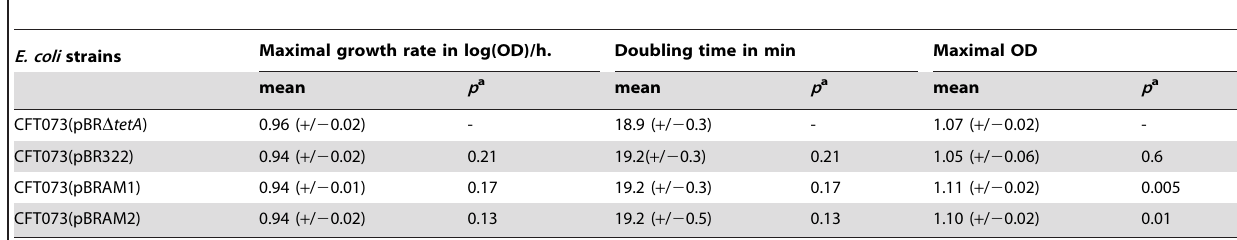
Table 2. In vitro growth parameters for the strains of the first isogenic system based on E. coli CFT073 carrying pBR322 derivatives harboring qnrA3 or not.